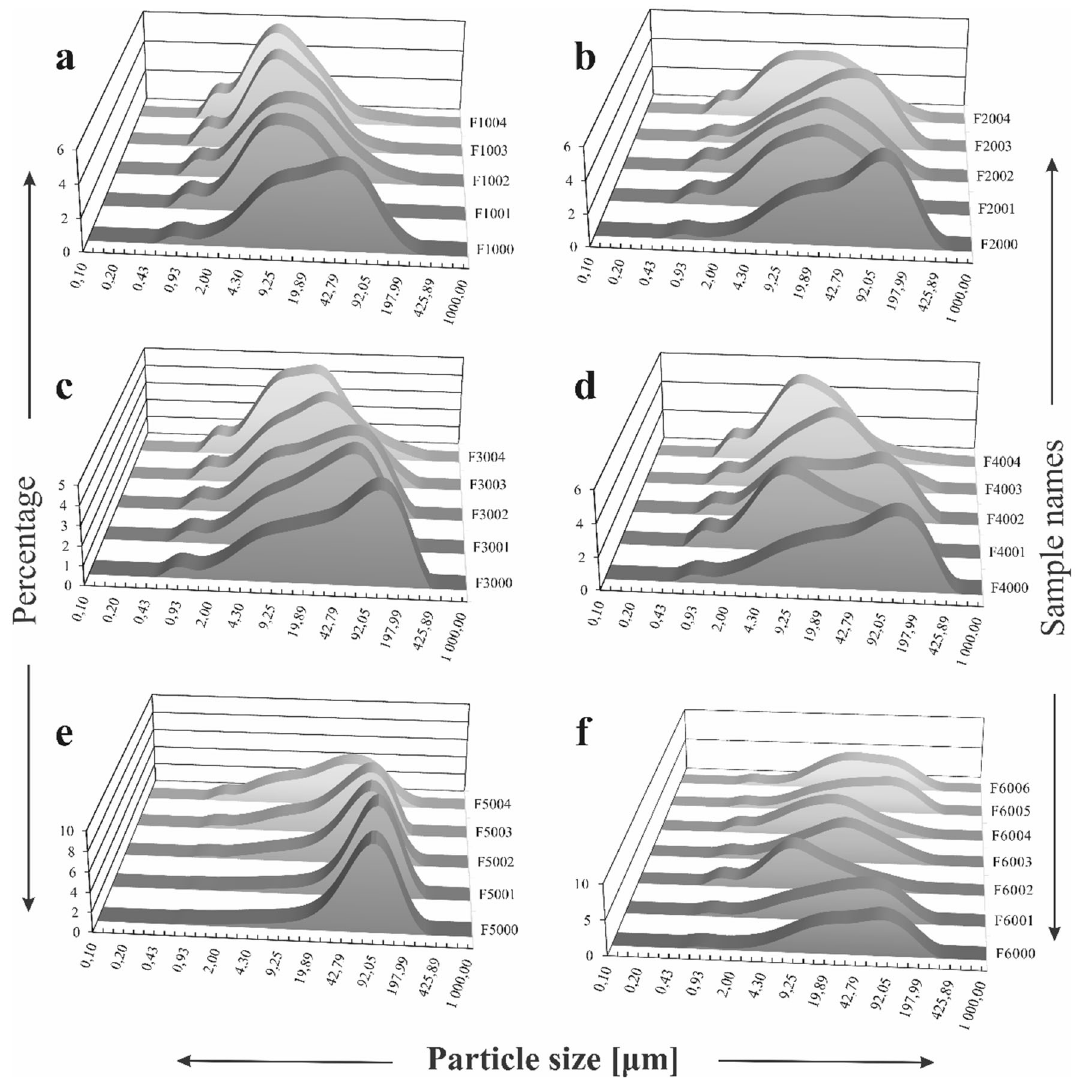
Fig. 1 Particle size analysis of raw fly ashes with their derivatives after grinding process ( a FA Skawina, b FA Siekierki, c FA Jaworzno, d